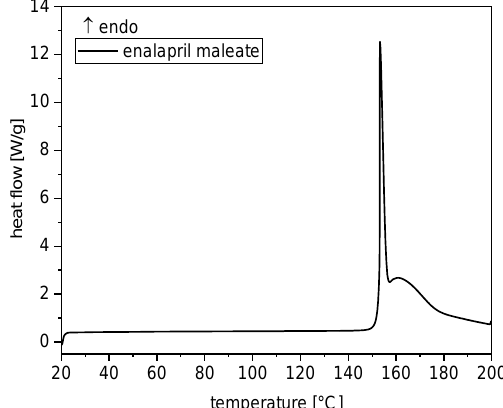
Figure 4. DSC thermogram of enalapril maleate starting material.